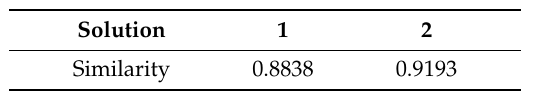
Table 8. Integral similarities of the two matching solutions.